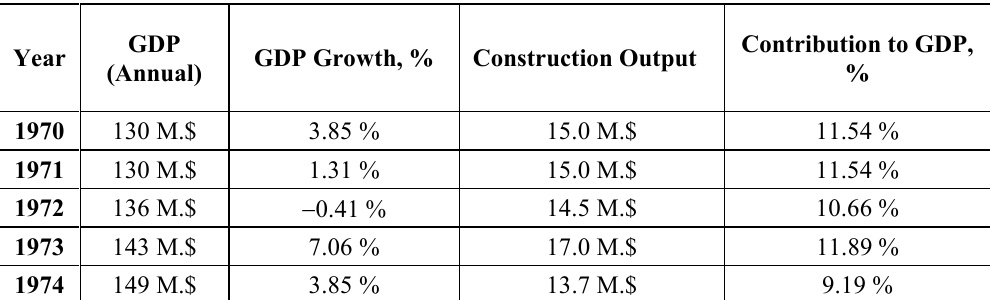
Table 1. GDP and Construction Output in Sri Lanka (1970–1974) (Ganesan,